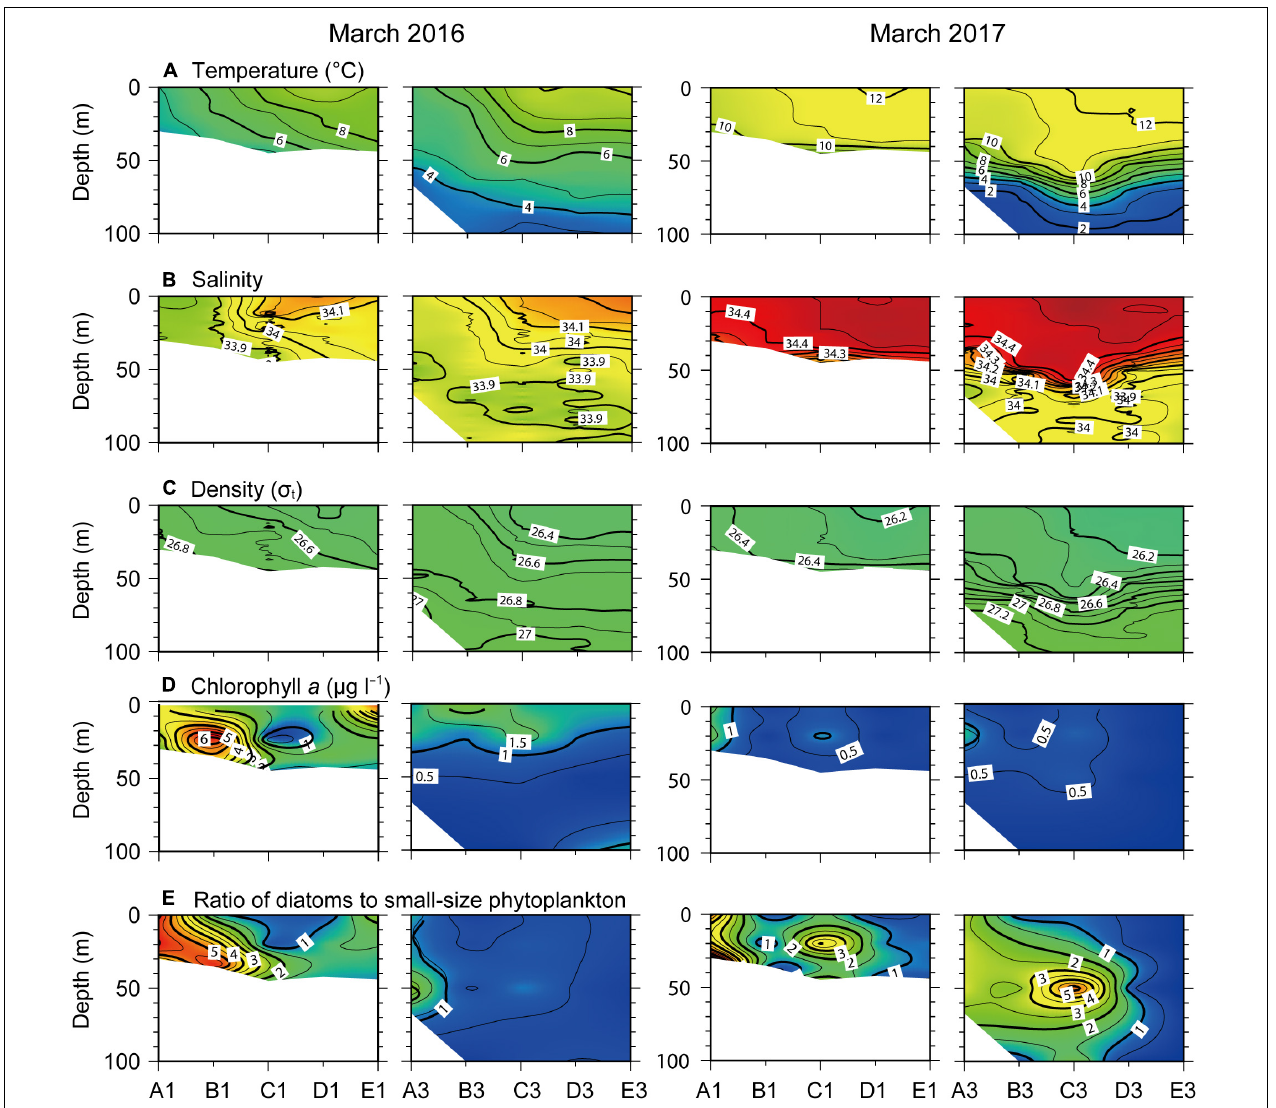
FIGURE 3 | Vertical profiles of (A) temperature, (B) salinity, (C) density, (D) chlorophyll a concentration, and (E) ratio of diatoms to small-sized ( < 20 µ m) phytoplanktons across the north–south longitudinal transects of the nearshore (left) and offshore (right) stations (see Figure 1 ) in March 2016 and 2017.